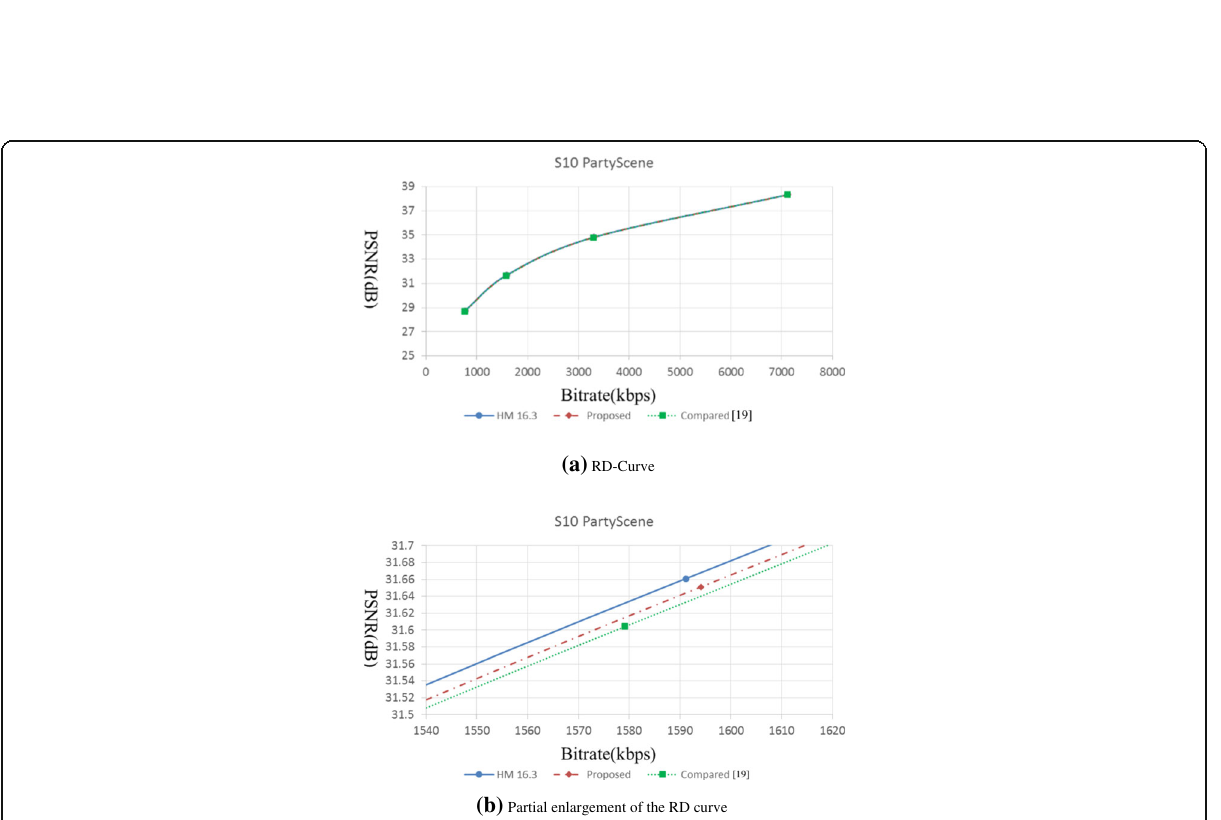
Fig. 16 RD-curve comparison of S10 (PartyScene) under random-access configuration. ( a ) RD-curve. ( b ) partial enlargement of the